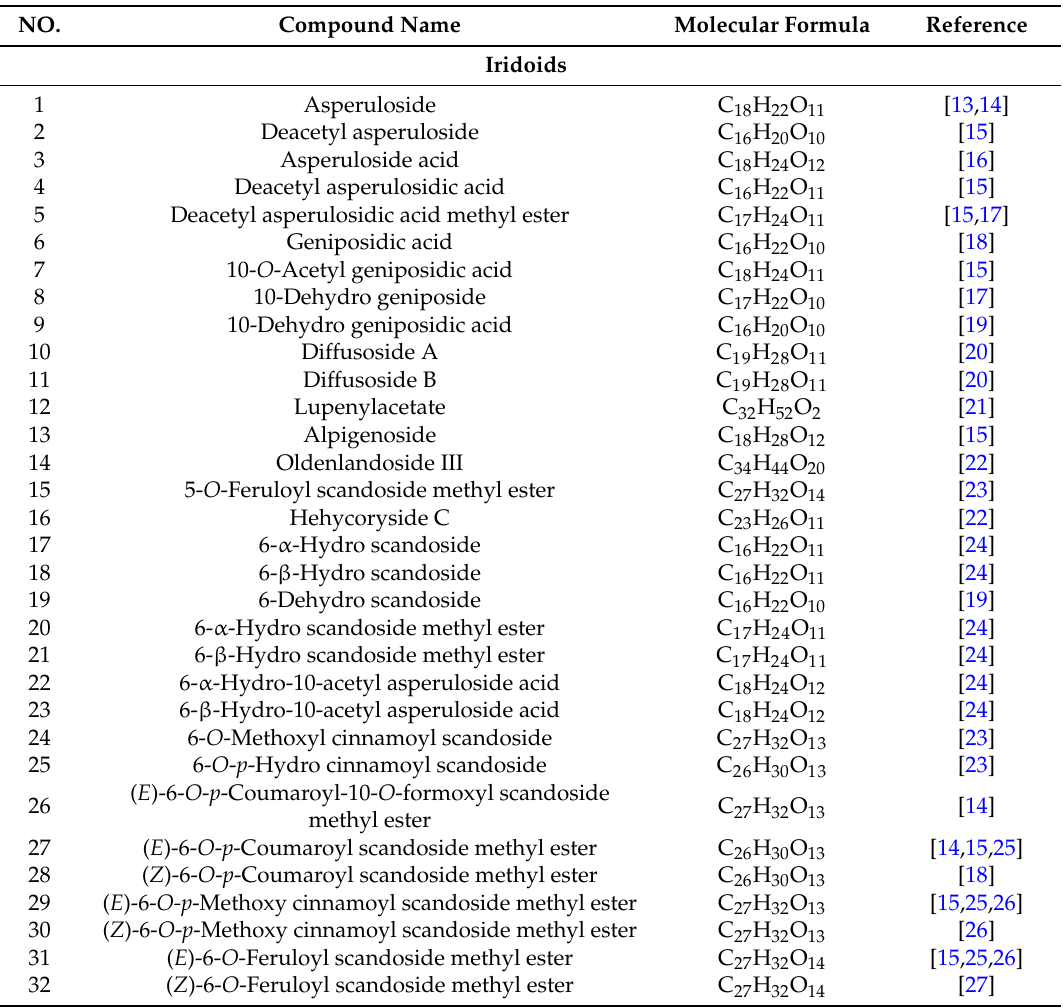
Table 1. Compounds of the H. diffusa